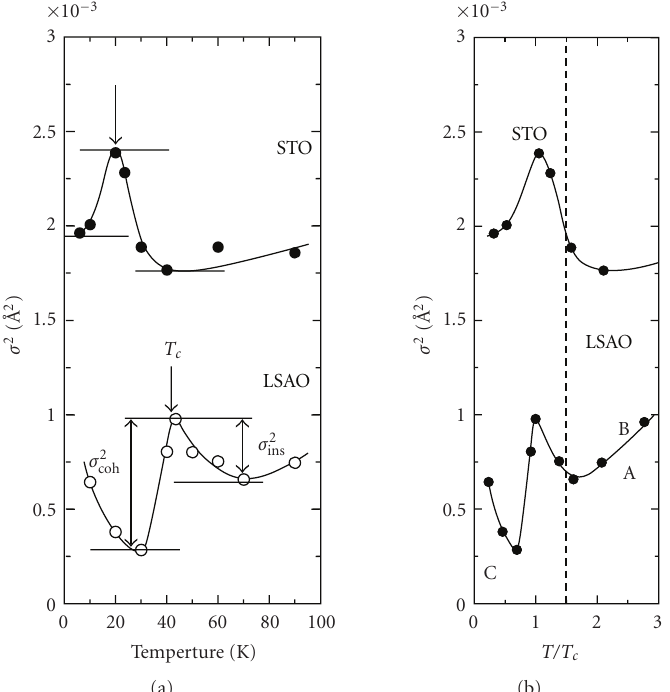
Figure 6: Mean-square relative displacement of the in-plane Cu–O bond in thin film single crystal La 1 − x Sr x CuO 4 ( x = 0 . 15) plotted against temperature (a) and normalized temperature T / T c (b), taken from